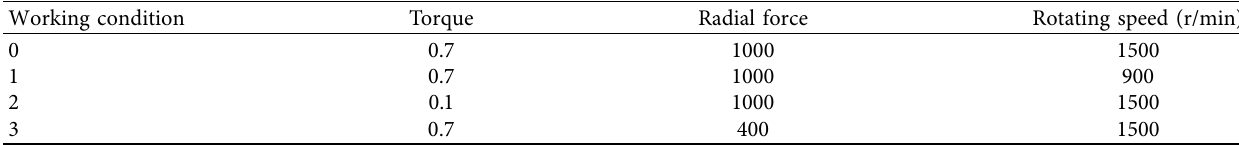
Table 4: Four working